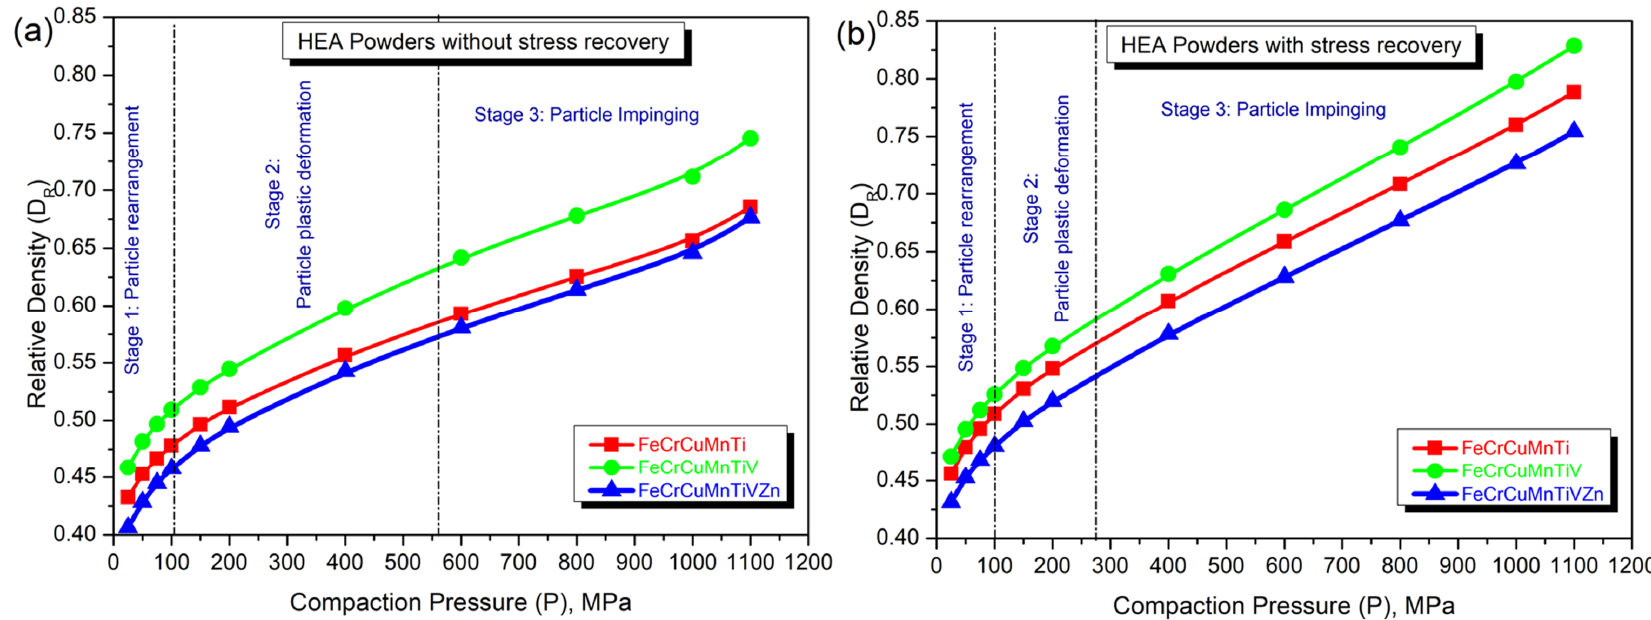
Figure 10. Compaction behavior of three developed high entropy alloy powders of FeCrCuMnTi, FeCrCuMnTiV, and FeCrCuMnTiVZn with different conditions: ( a ) without stress recovery and ( b ) with stress recovery.